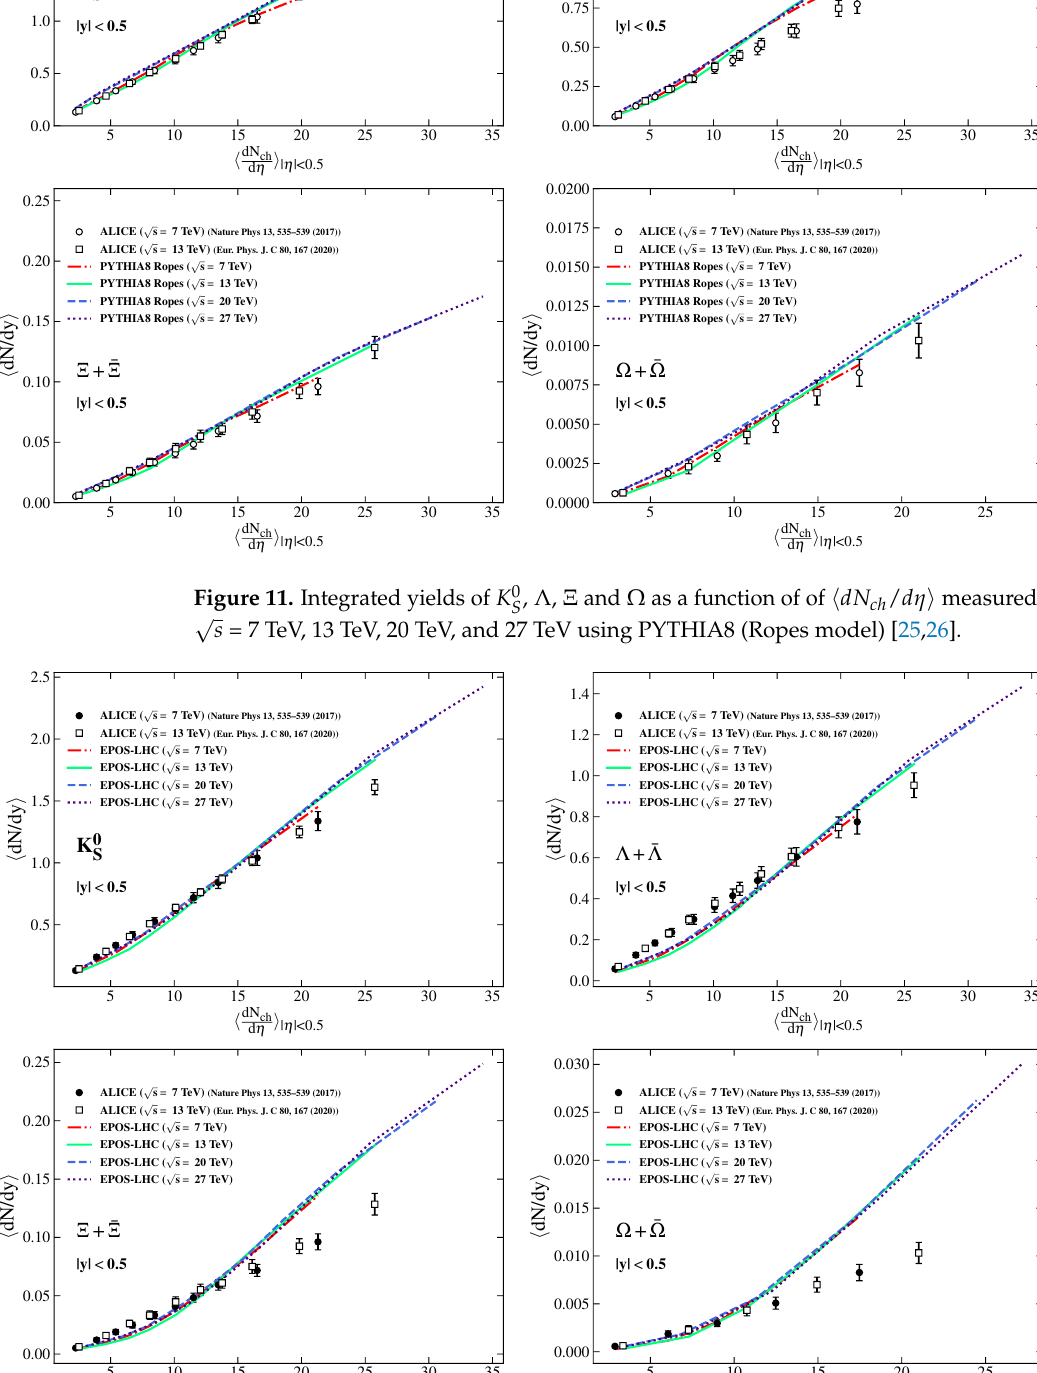
< 0.5 dN ch / d η y measured in (cid:104) (cid:105) | |